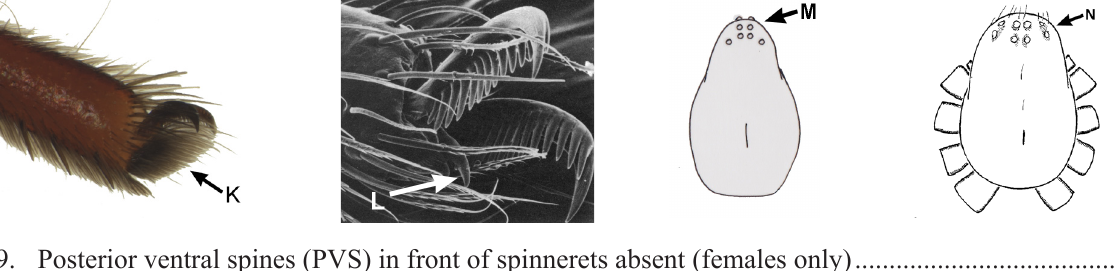
Posterior ventral spines in front of spinnerets present (Q) .............................................................. 10 area ................................................................................................................. Mallinella Strand, 1906 Posterior ventral spines arranged in a group or more than one row (R) ...........................................11